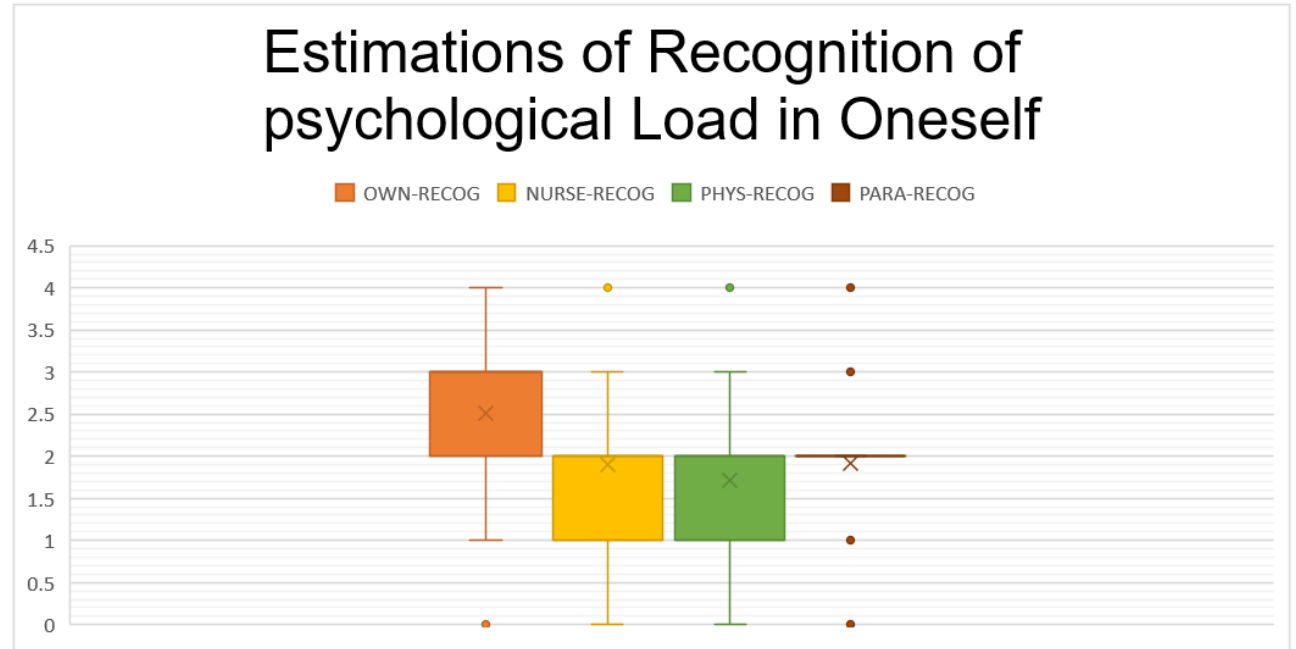
Figure 3. Estimations of one’s own and others’ ability to detect SVP in oneself, for own nurses (NURSE), Physicians (PHYS) and Paramedics (PARA) competencies. Y -axis displays points according to the Likert scale with a minimum of 0 and a maximum of 4. Again, respondents rated their own competencies higher than others’ competencies.